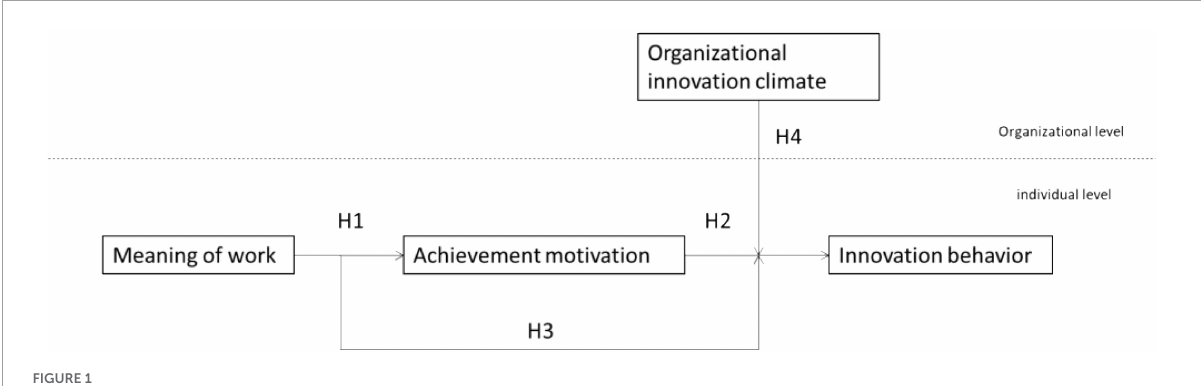
FIGURE1 Theoretical model of the